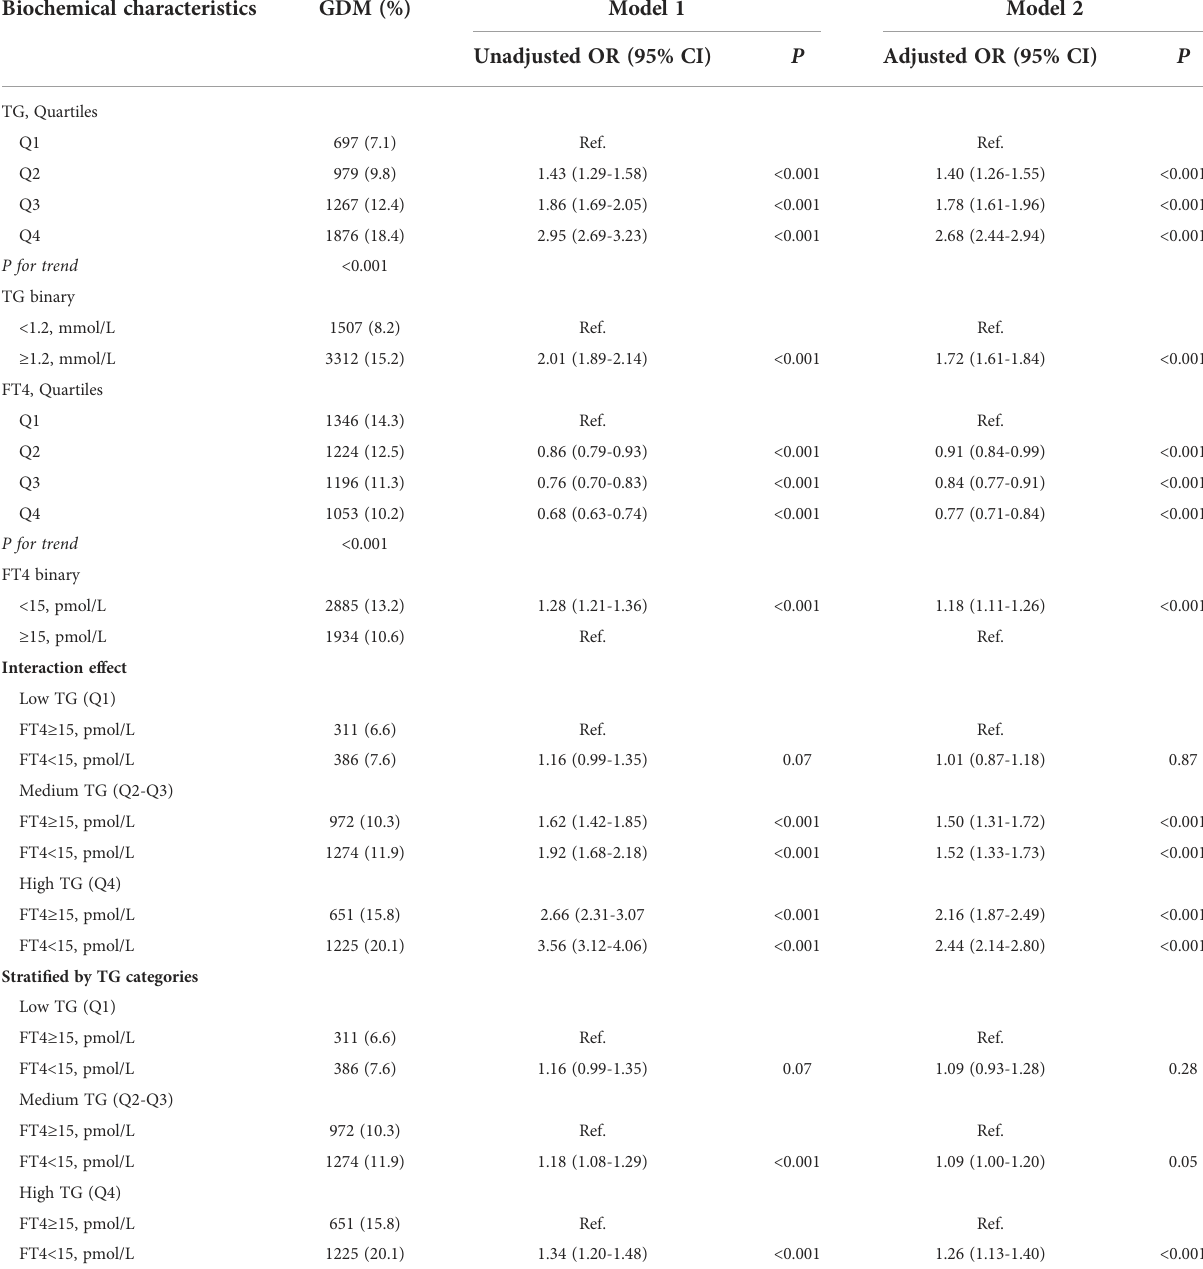
TABLE 4 Combined effect of maternal free triiodothyronine 4 and triglycerides categories on gestational diabetes mellitus risk. Biochemical